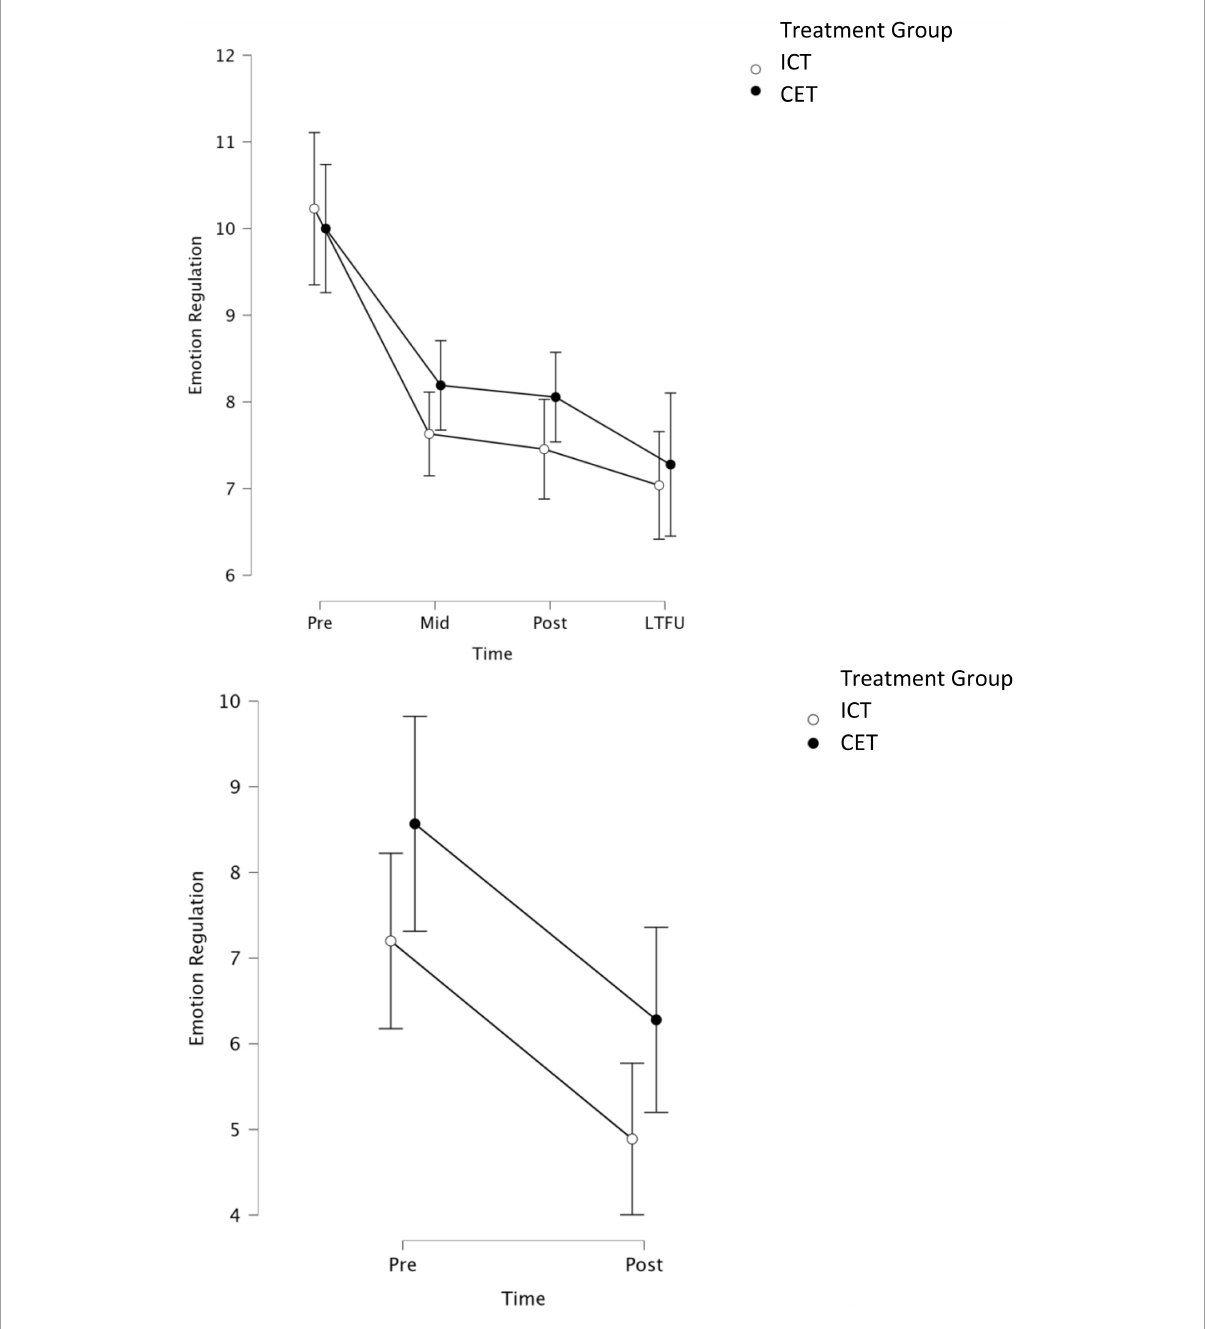
FIGURE3 Graphical representation of parent-reported (top) and teacher-reported (bottom) models, with BASC-3 emotional self-control and negative emotionality subscales collapsed within each time point for each informant. Parent ratings were obtained at pre, mid, post, and LTFU. Teacher ratings were obtained at pre and 1–2 months post-treatment. LTFU, long-term follow-up (2–4 months after treatment